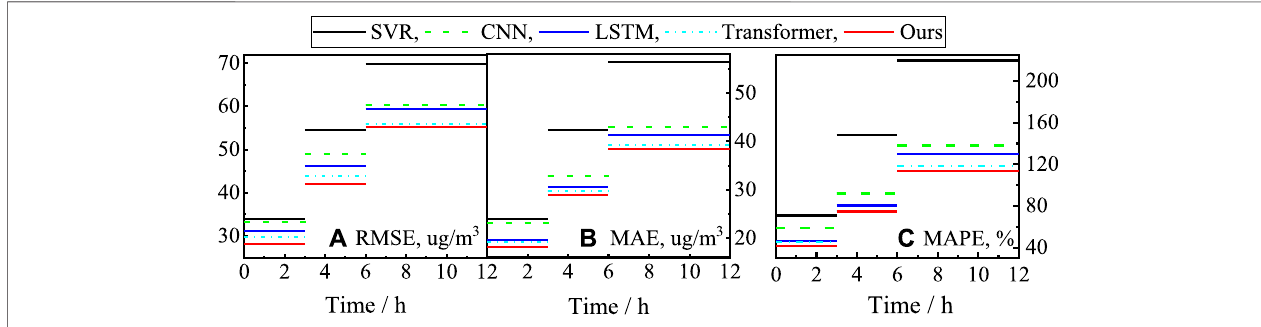
FIGURE 8 | Comparisons of different methods for multi-step prediction results for the next 12 h on Beijing dataset.